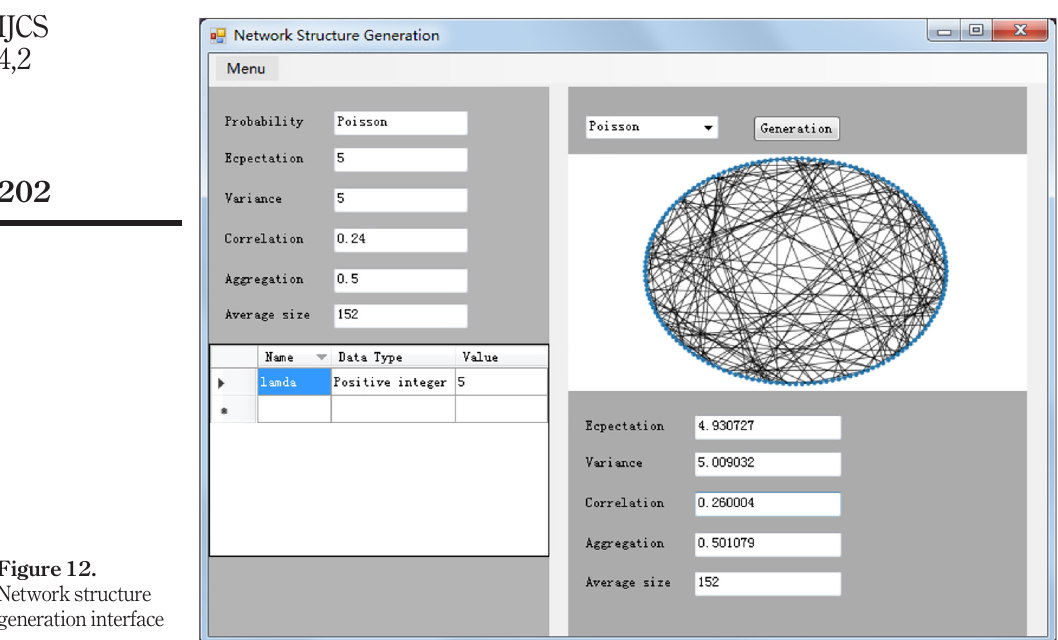
Figure 12. Network structure generation